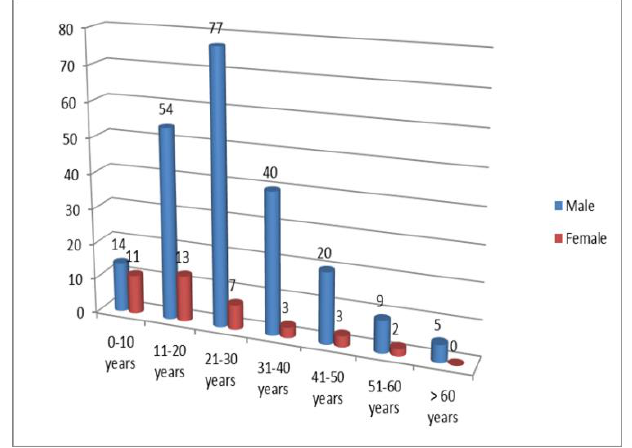
Fig. 2. Number of the patient according to age range (n = 260).